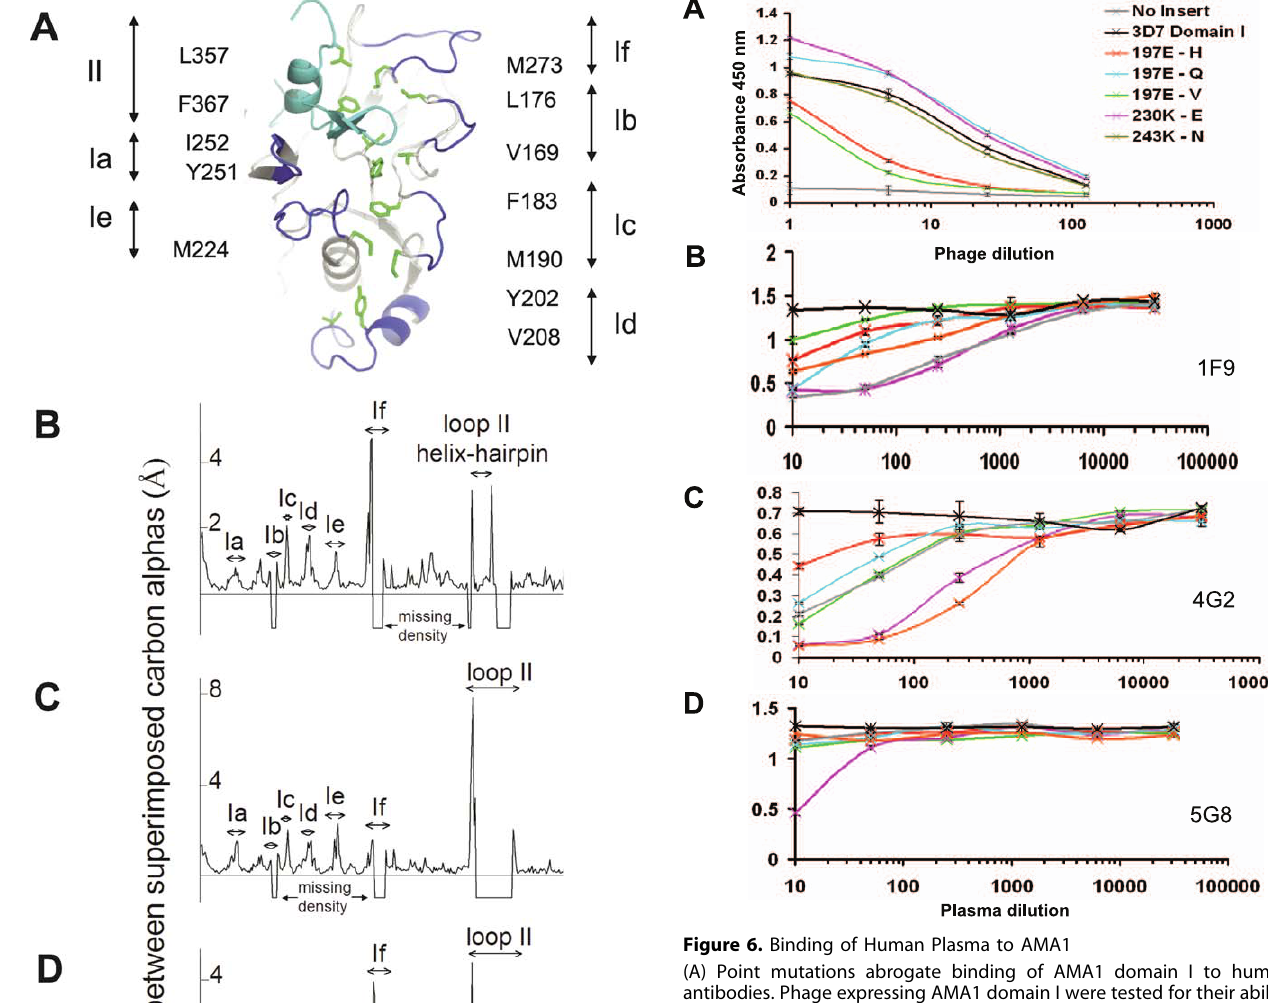
human plasma to compete with 1F9 for AMA1 binding was were pre-screened for their ability to recognize recombinant